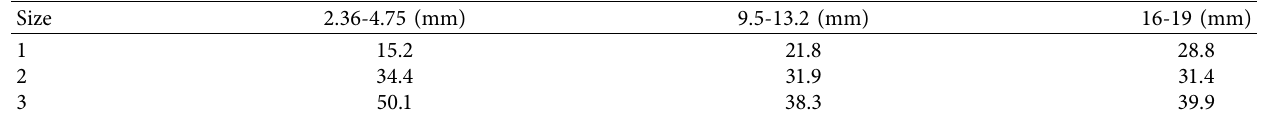
Table 5: Detected value of indoor gravel distribution rate in this method (%).